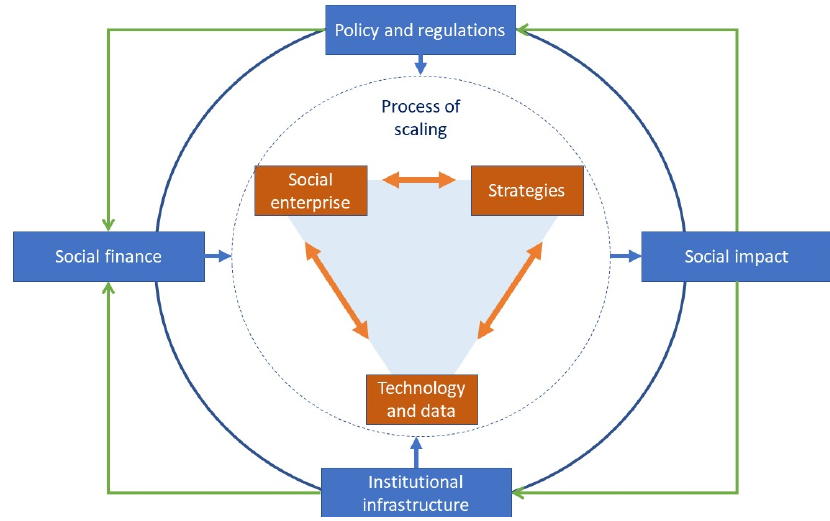
Figure 1. Selected elements of an ecosystem for social enterprises. Source: Authors.